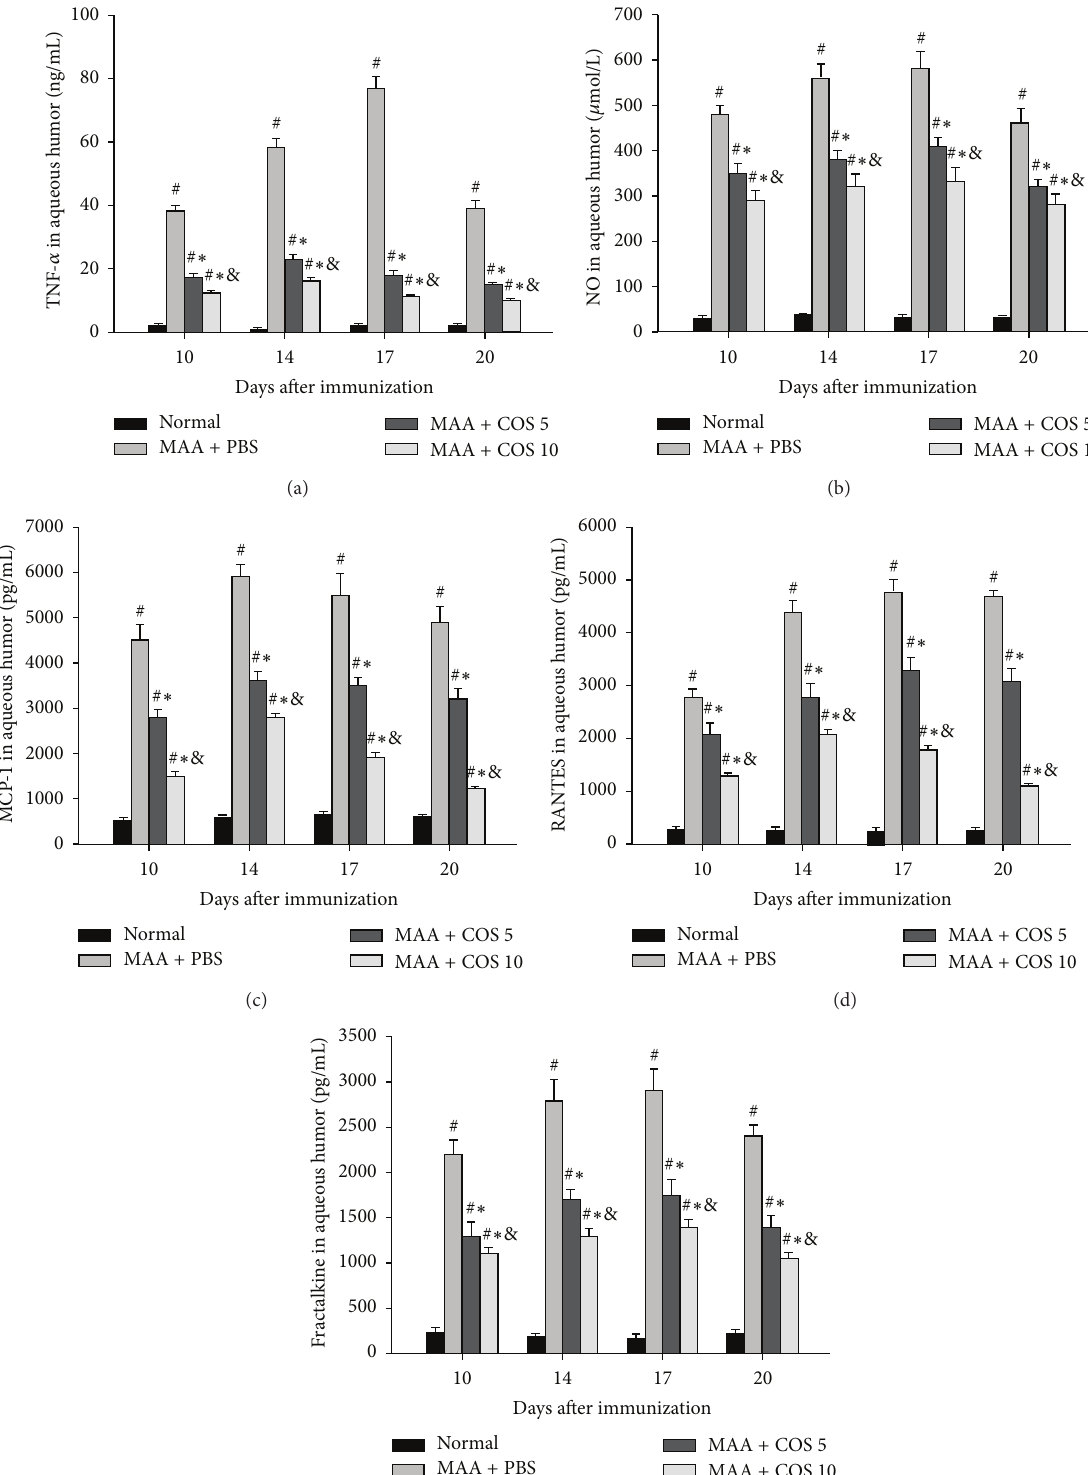
Figure 5: Quantification of the levels of (a) TNF- 𝛼 , (b) iNOS, (c) MCP-1, (d) RANTES, and (e) fractalkine at days 10, 14, 17, and 20 in the AqH.DecreasedexpressionlevelsofTNF- 𝛼 ,iNOS,MCP-1,RANTES,andfractalkinewereobservedinthelow-doseorhigh-doseCOSgroups compared with the levels in the PBS-treated group. The AqH was pooled from one eye of five rats in each group. The data are expressed as the mean ± SD ( ∗ 𝑃 < 0.05 compared with the PBS-treated group; # 𝑃 < 0.05 compared with the normal group; & 𝑃 < 0.05 compared with the low-dose group by Kruskal-Wallis 𝐻 test with post hoc Dunn test; 𝑛 = 5 for each group in each time